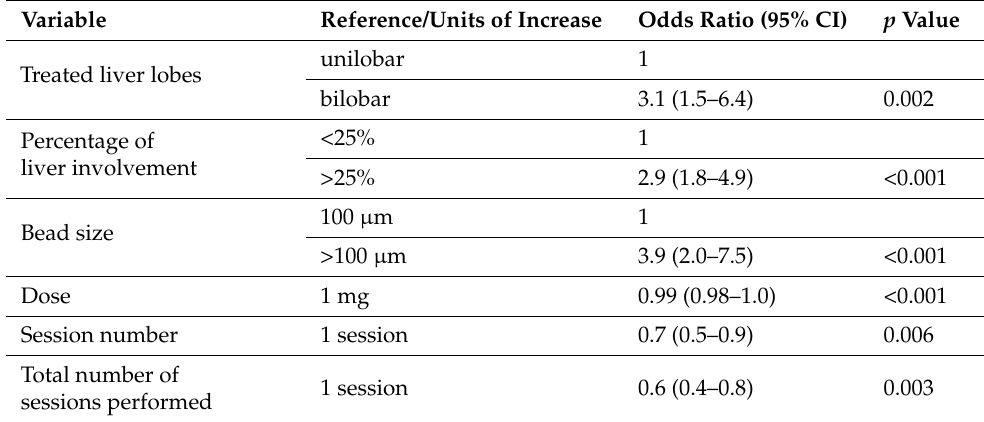
Table 3. Multivariable binary logistic regression analysing the relationship between baseline- and treatment associate factors and sessions with ≥ 1 peri-interventional AEs. Following variables were considered in the multivariable model: ECOG, treated liver lobes, percentage of liver involvement, bead size, dose, session number and total number of sessions performed.